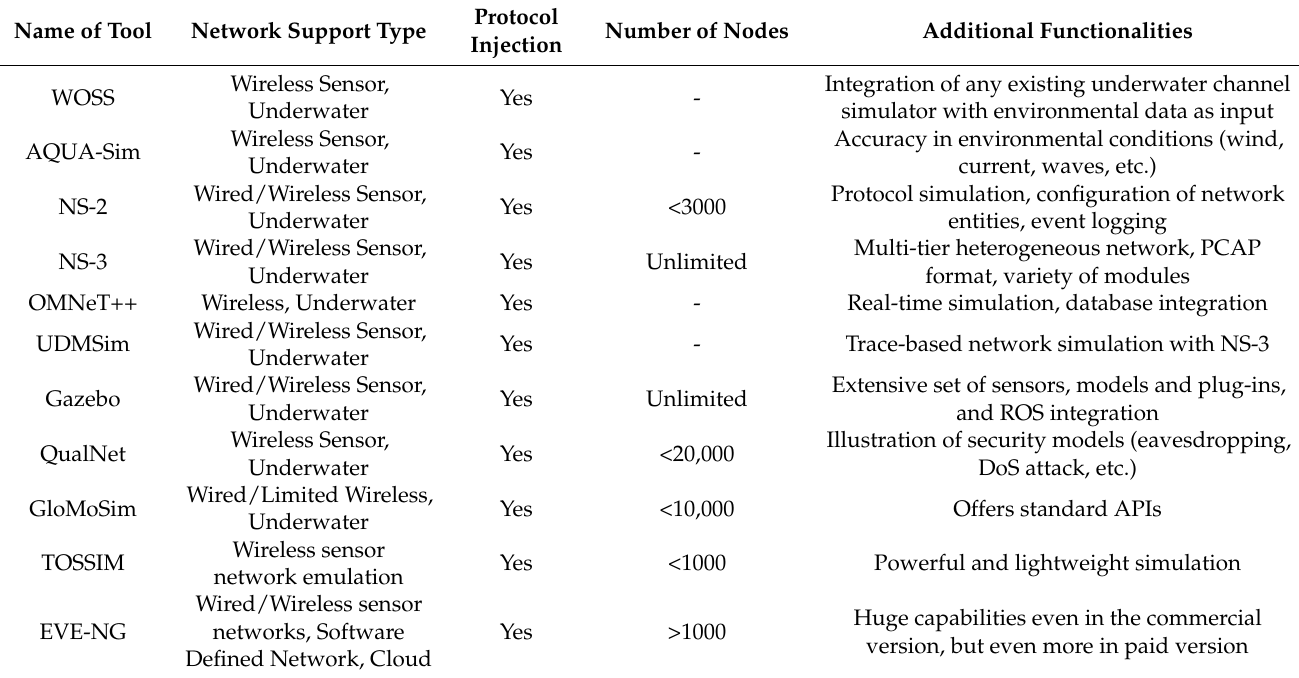
Table 4. Comparison of network simulation tools based on properties of